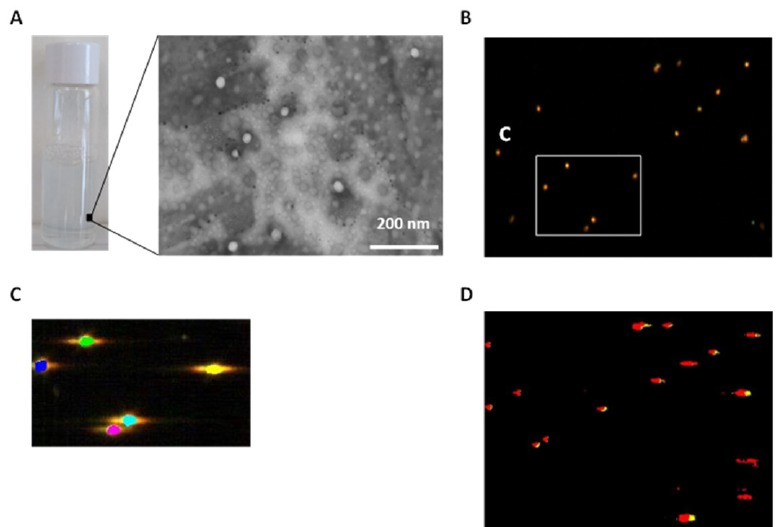
Figure 1. ( A ): Biophysical characterization of RA-loaded PLGA NPs: ( A ): Physical appearance and TEM microscopy image. Scale bar = 200 nm; ( B ): Dark-field microscopy image at 100 × magnification; ( C ): Dark-field hyperspectral image selection; ( D ): Mapped region of RA-loaded PLGA NPs. Colour code for RA-loaded PLGA NPs: PLGA (red) and RA (yellow). The scattering spectra of PLGA and RA-loaded PLGA NPs are displayed in Figure S4. Table 1. Biophysical characterization of PLGA and RA@PLGA polymeric NPs 1 .